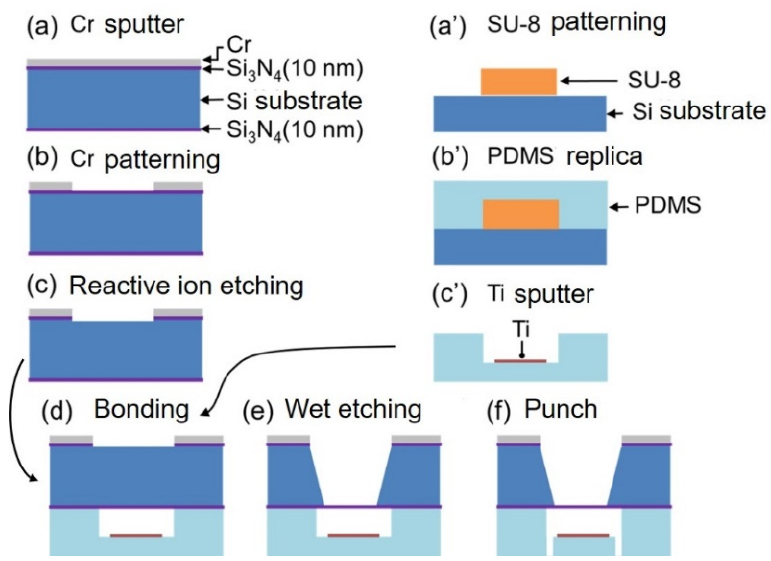
Figure 4. Fabrication process of the microfluidic liquid cell with the super-thin ETM.